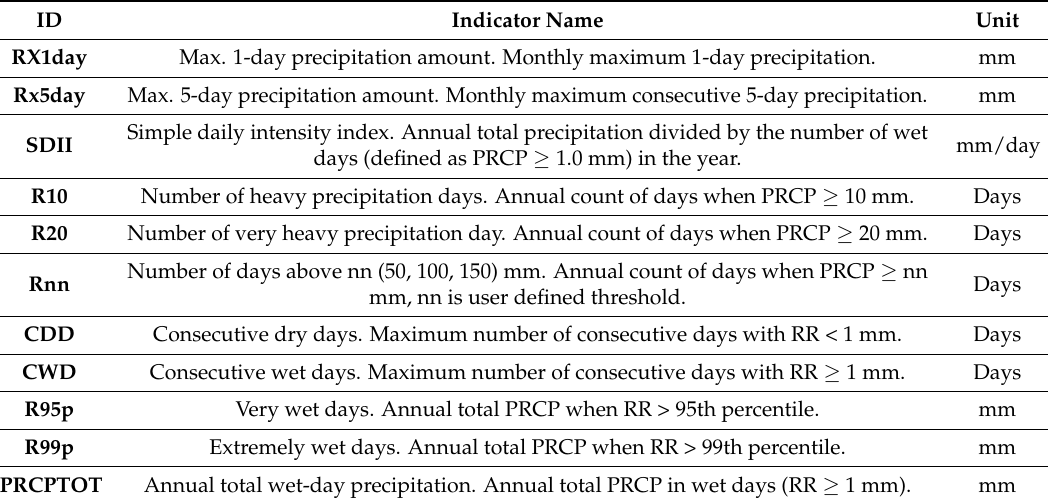
Table 2. RClimdex precipitation